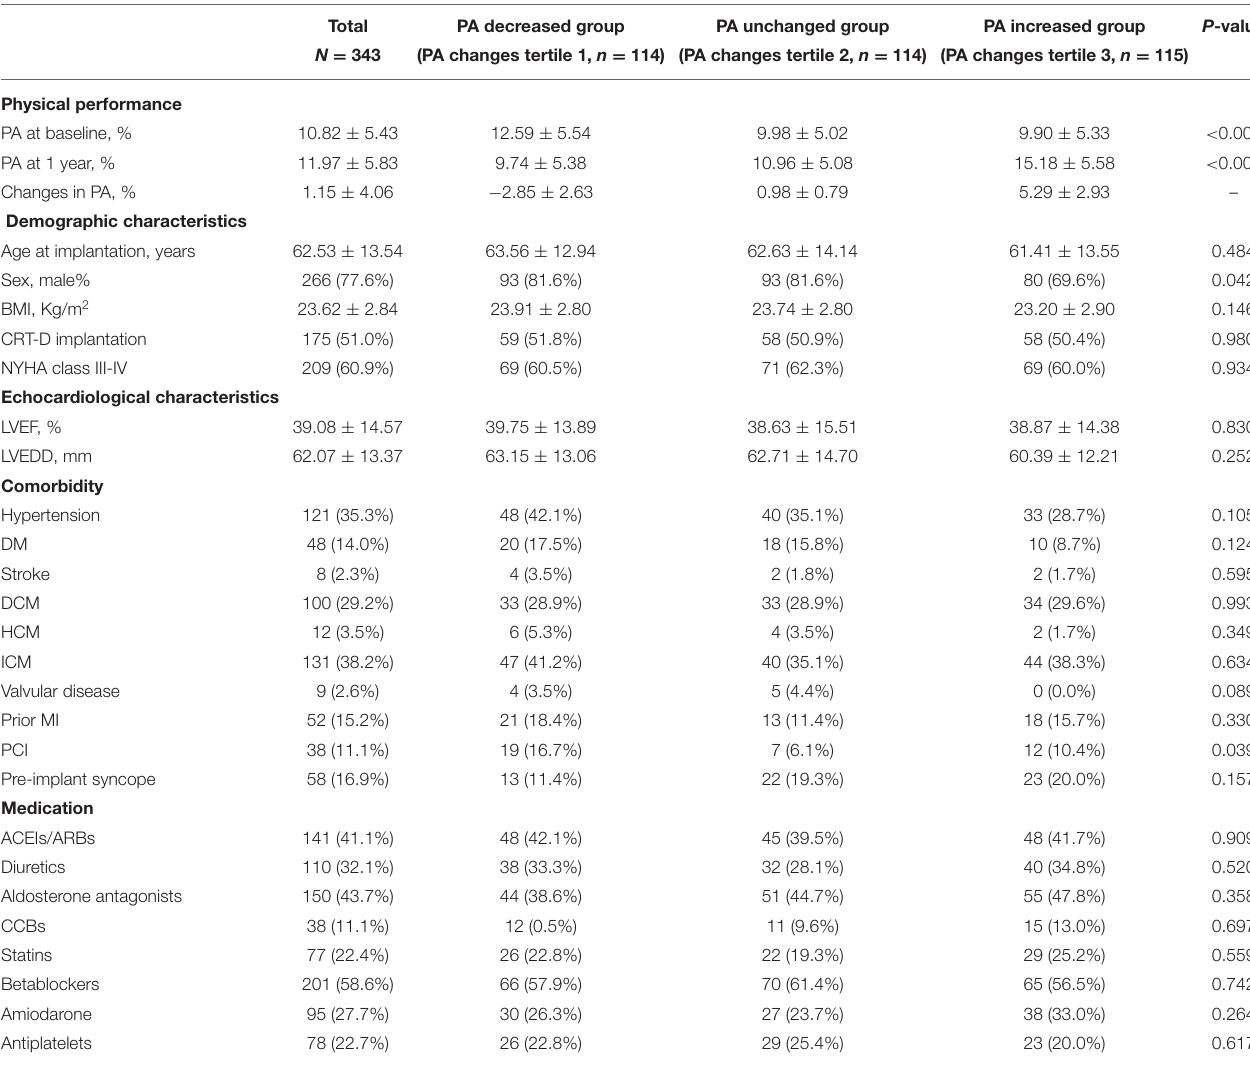
TABLE 1 | Baseline